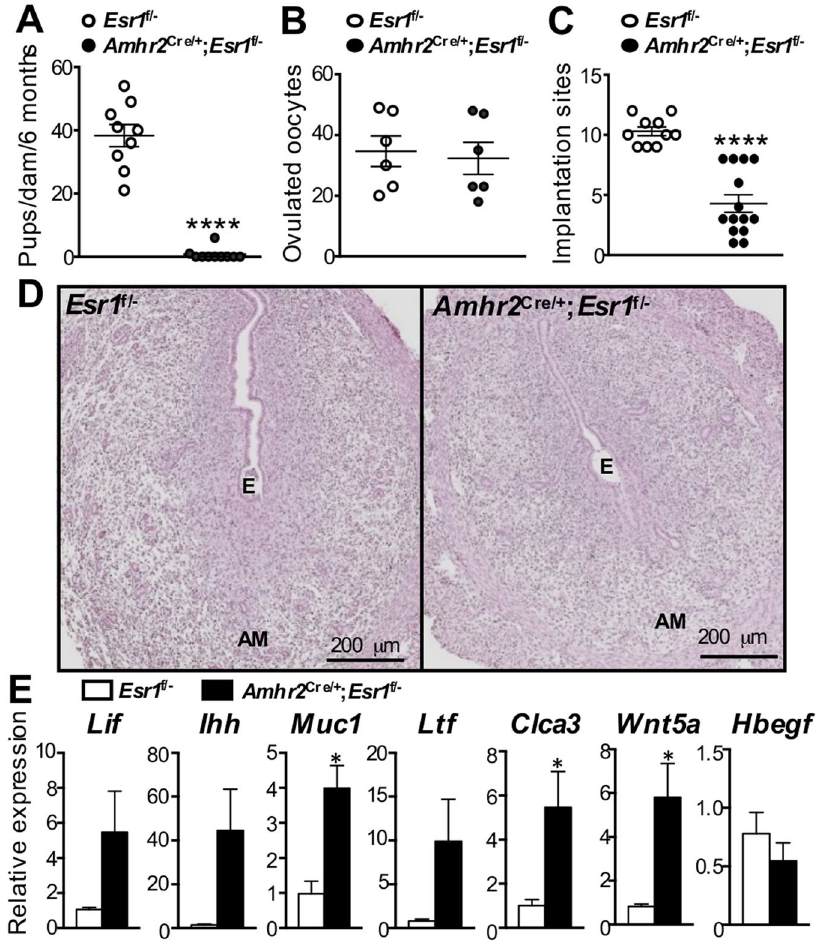
Figure 5. Fertility study of Amhr2 Cre/ + ; Esr1 f/ − and Esr1 f/ − mice. ( A ) Number of total pups per dam during 6-month breeding trial with wild-type males. Each data point represents an individual dam. **** p < 0.0001; unpaired t- test. N = 9–10 mice/genotype. ( B ) Ovulatory responses of 3–5-week-old females to gonadotropins indicated by total number of ovulated oocytes/mice. N = 6 mice/genotype. ( C ) Total number of 4.5 dpc implantation sites in 8–12-week-old female mice after natural mating. **** p < 0.0001; unpaired t- test. N = 3–4 mice/genotype. ( D ) Hematoxylin and eosin staining of implantation sites (4.5 dpc) in uterine cross sections. N = 3–4 mice/genotype. E = embryo, M = Mesometrium, AM = Anti-mesometrium. ( E ) Expression of implantation markers ( Lif , Ihh , Wnt5a , and Hbegf ) and E 2 -target transcripts ( Muc1 , Ltf , and Clca3 ) at 3.5 dpc in Esr1 f/ − and Amhr2 Cre/ + ; Esr1 f/ − 8–12-week-old female mice. * p < 0.05; unpaired t- test. N = 5–6 mice/genotype. All graphs represent mean ± SEM. Representative images